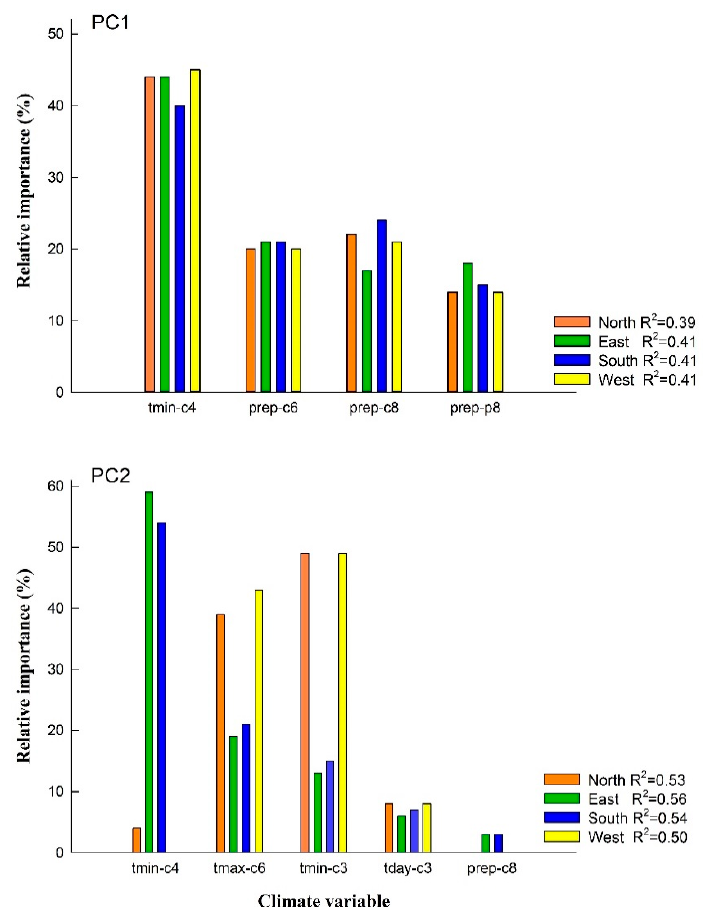
Figure 5. The relative importance of climate variable on radial growth in PC1 and PC2 groups. Direction-specific differences ( Δ 𝑟 (cid:2870) ) in climate–growth relationships were almost in- significant according to the Wilcoxon signed-rank tests, except for prep-c8 (with E-S and S-W) and tmax-c6 (with E-W and S-W). This suggests that there is the potential for prep-c8 to affect the growth differences between south and east or between south and west, and for tmax-c6 to affect the growth differences between west and east or west and south. This result included all the factors driving tree growth variability. Combined with Figure 5, tmax-c6 was the main reason for the differences between east and west and between west and south. The mean Δ 𝑟 (cid:2870) of tday-c3, tmin-c3, tmin-c4, and tmax-c6 was higher in the east than in other directions, suggesting that growth in the east side of the tree is more sensitive to temperature than in other directions. The mean Δ 𝑟 (cid:2870) of prep-c6 and prep-c8 were higher in the south than in other directions, suggesting that growth in the south side of the tree is more sensitive to current precipitation than in other directions (Figure 6).